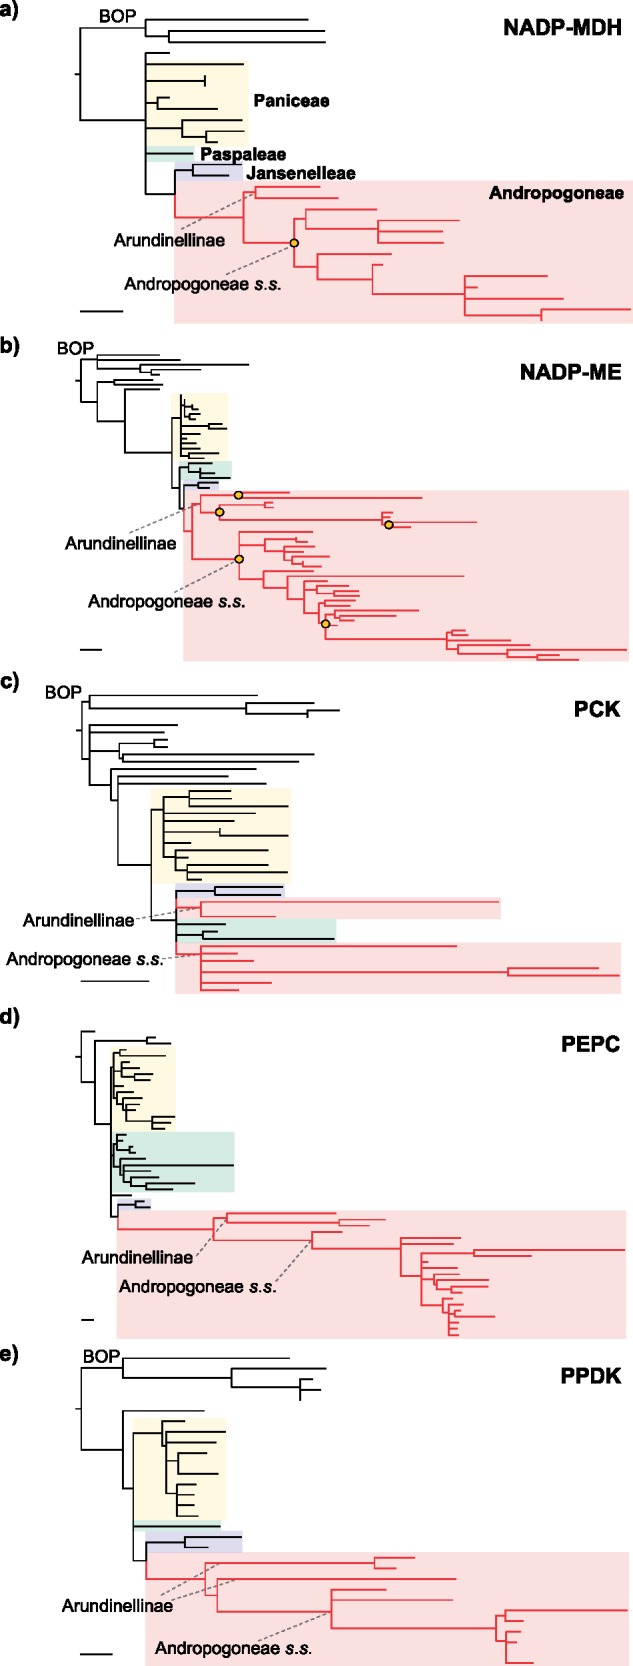
Phylograms with branch lengths based on amino acid sequences. The tree topologies were fixed to those obtained using third positions of codons for genes encoding five core C\documentclass[12pt]{minimal}
\usepackage{amsmath}
\usepackage{wasysym}
\usepackage{amsfonts}
\usepackage{amssymb}
\usepackage{amsbsy}
\usepackage{upgreek}
\usepackage{mathrsfs}
\setlength{\oddsidemargin}{-69pt}
\begin{document}
}{}$_{4}$\end{document} enzymes: (a) NADP-malate dehydrogenase (NADP-MDH, gene nadpmdh-1P1), (b) NADP-malic enzyme (NADP-ME, gene nadpme-1P4), (c) phosphoenolpyruvate carboxykinase (PCK, gene pck-1P1), (d) phosphoenolpyruvate carboxylase (PEPC, gene ppc-1P3), and (e) pyruvate phosphate dikinase (PPDK, gene ppdk-1P2). The major taxonomic groups are indicated with shades, and branches from C\documentclass[12pt]{minimal}
\usepackage{amsmath}
\usepackage{wasysym}
\usepackage{amsfonts}
\usepackage{amssymb}
\usepackage{amsbsy}
\usepackage{upgreek}
\usepackage{mathrsfs}
\setlength{\oddsidemargin}{-69pt}
\begin{document}
}{}$_{4}$\end{document}Andropogoneae are in red. Yellow circles indicate gene duplications. Scale bars = 0.01 expected amino acid substitutions per site (panels a–e are depicted at different scales). C\documentclass[12pt]{minimal}
\usepackage{amsmath}
\usepackage{wasysym}
\usepackage{amsfonts}
\usepackage{amssymb}
\usepackage{amsbsy}
\usepackage{upgreek}
\usepackage{mathrsfs}
\setlength{\oddsidemargin}{-69pt}
\begin{document}
}{}$_{4}$\end{document} species outside Andropogoneae were pruned from the tree. See Supplementary Fig. S7 available on Dryad for details, and Supplementary Fig. S6 available on Dryad for branch lengths based on nucleotides.